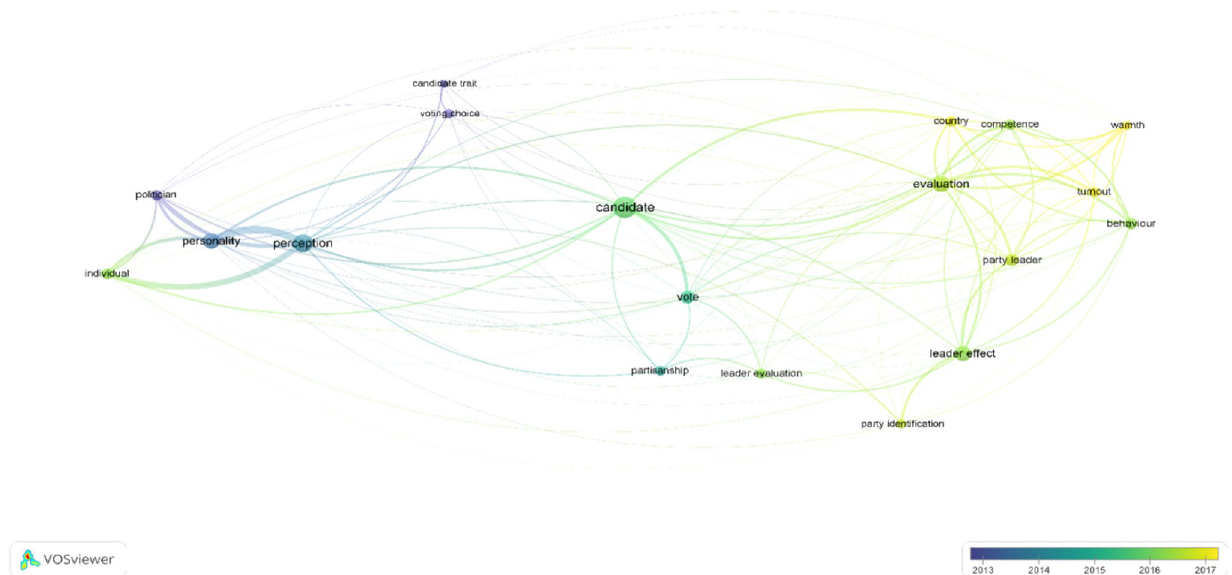
Fig. 2 Overlay map-based visualization on text data retrieded from title and abstract fields during full text screening. The color bar reflects how the publication year of the articles is mapped to colors. The nodes reflect the words that were most frequently used in the title and abstract fields of the literature that was screened in